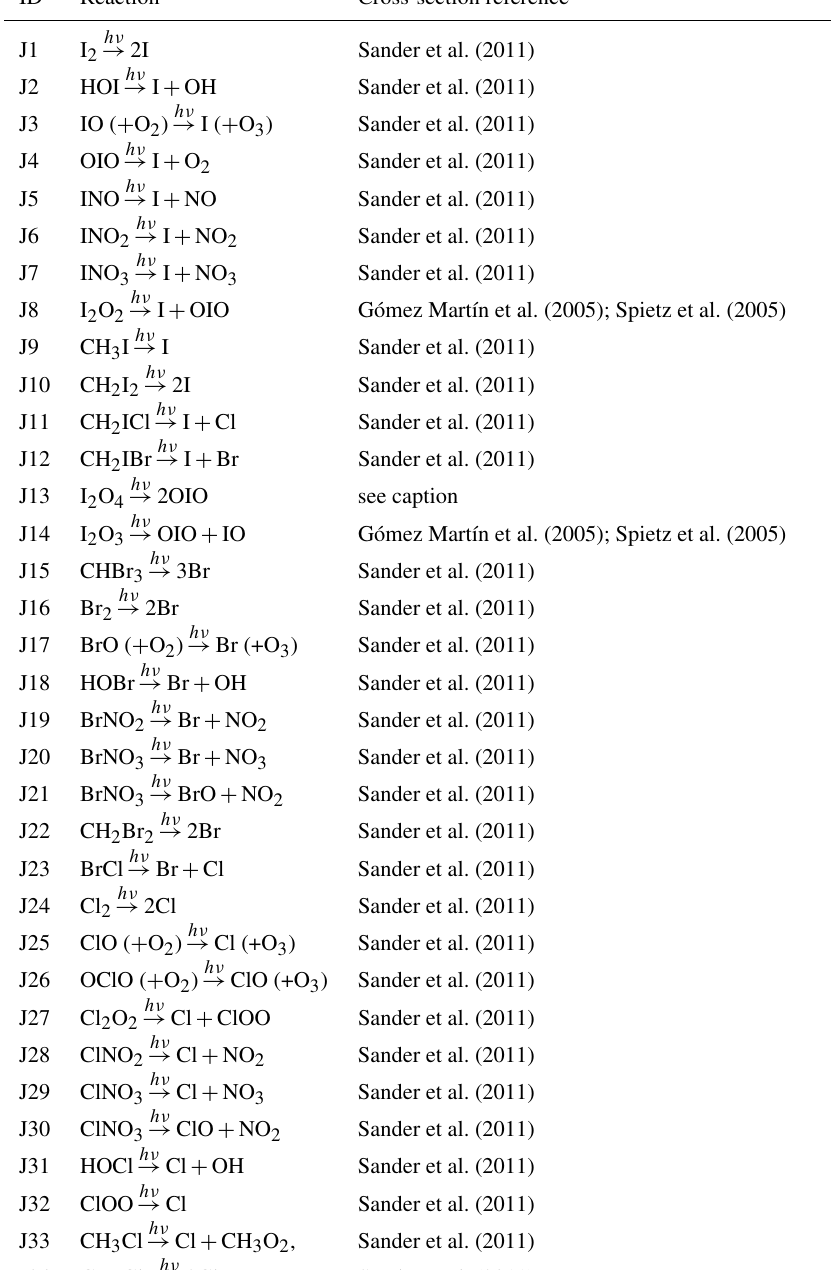
Table B1. Photolysis reactions of halogens included in scheme. Photolysis is described in Eastham et al. (2014) (ClNO 2 , ClNO 3 , and ClOO), Sherwen et al. (2016a) (I 2 , HOI, IO, OIO, INO, INO 2 , INO 3 , I 2 O 2 , I 2 O 3 , I 2 O 4 , CH 3 I, CH 2 I 2 , CH 2 ICl, and CH 2 IBr), and Schmidt et al. (2016) (BrCl, Cl 2 , ClO, HOCl, ClNO 2 , ClNO 3 , ClOO, Cl 2 O 2 , CH 3 Cl, CH 3 Cl 2 , and CHCl 3 ). As stated in Sect. 2, we have used the I 2 O 2 cross section for I 2 O 4